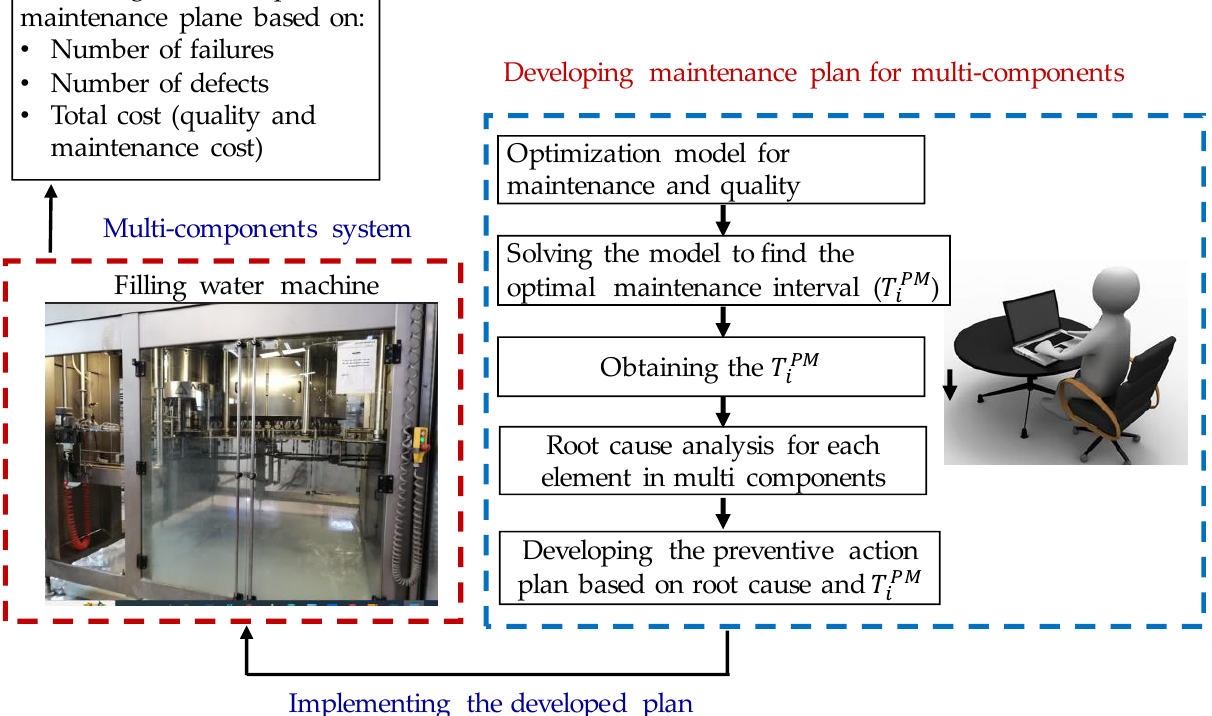
Figure 2. Flowchart for developing and implementing the predictive maintenance model.